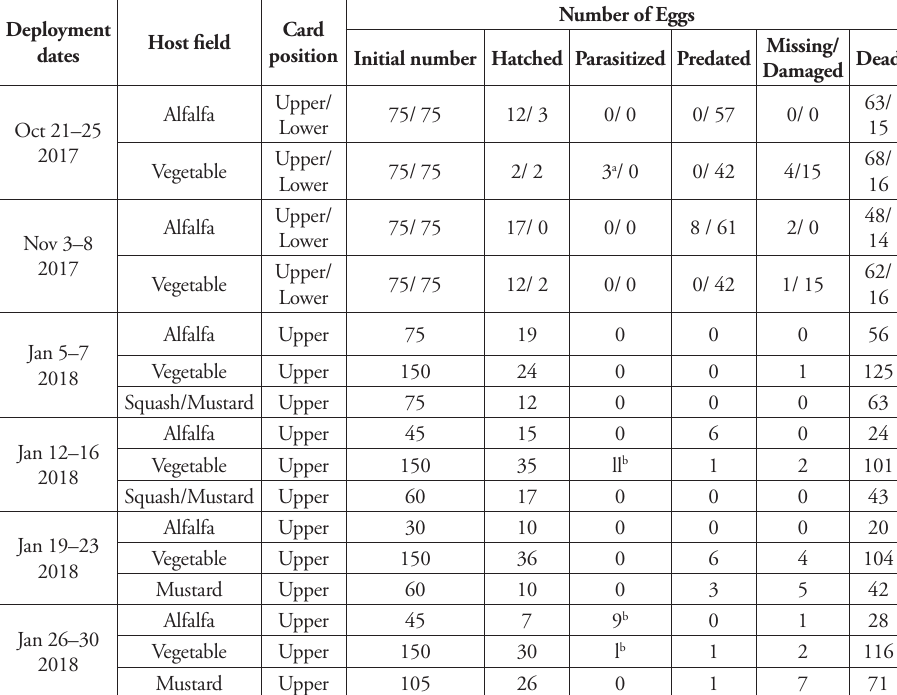
Table 1. Results of the sentinel Bagrada hilaris egg cards that were deployed in two host fields.